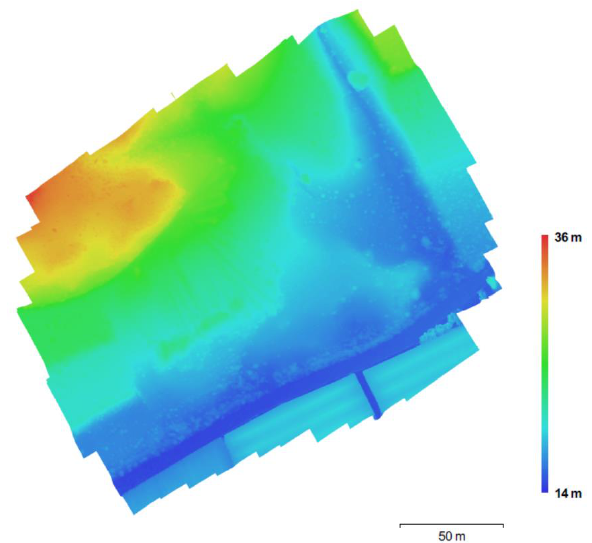
Figure 8. Reconstructed DEM of the damaged archaeological site